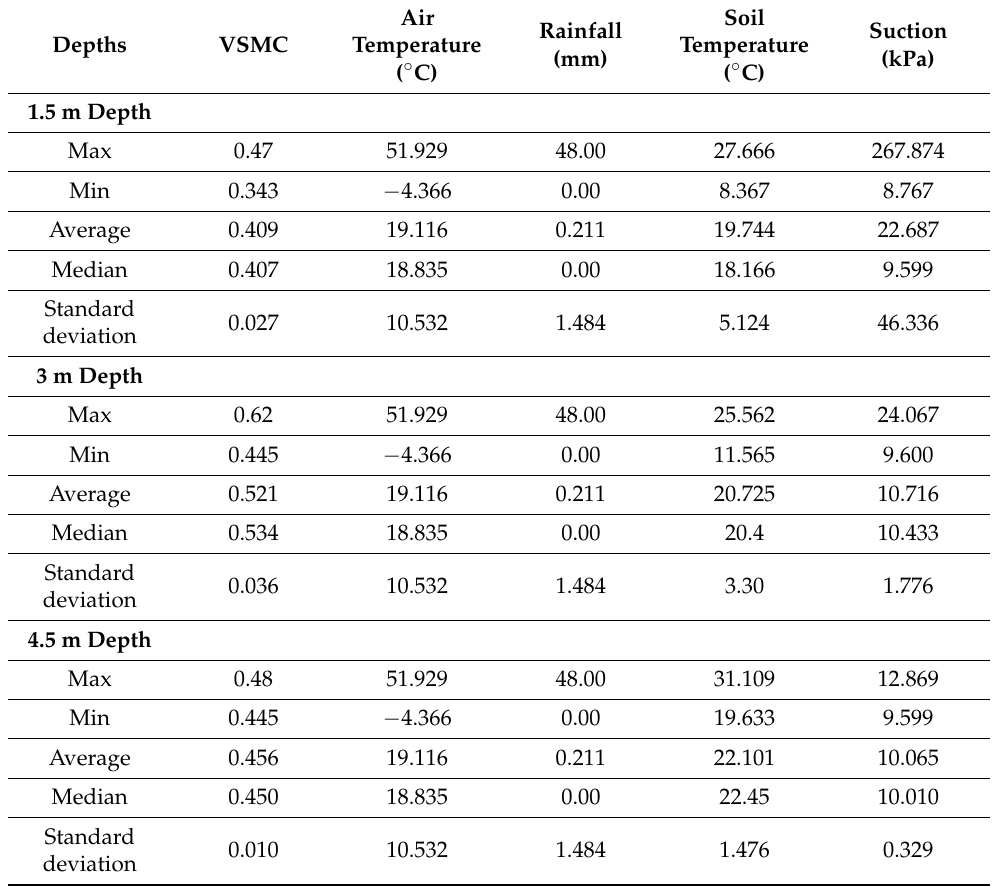
Table A1. Preliminary detailed statistics for the constructed dataset HWS 2.